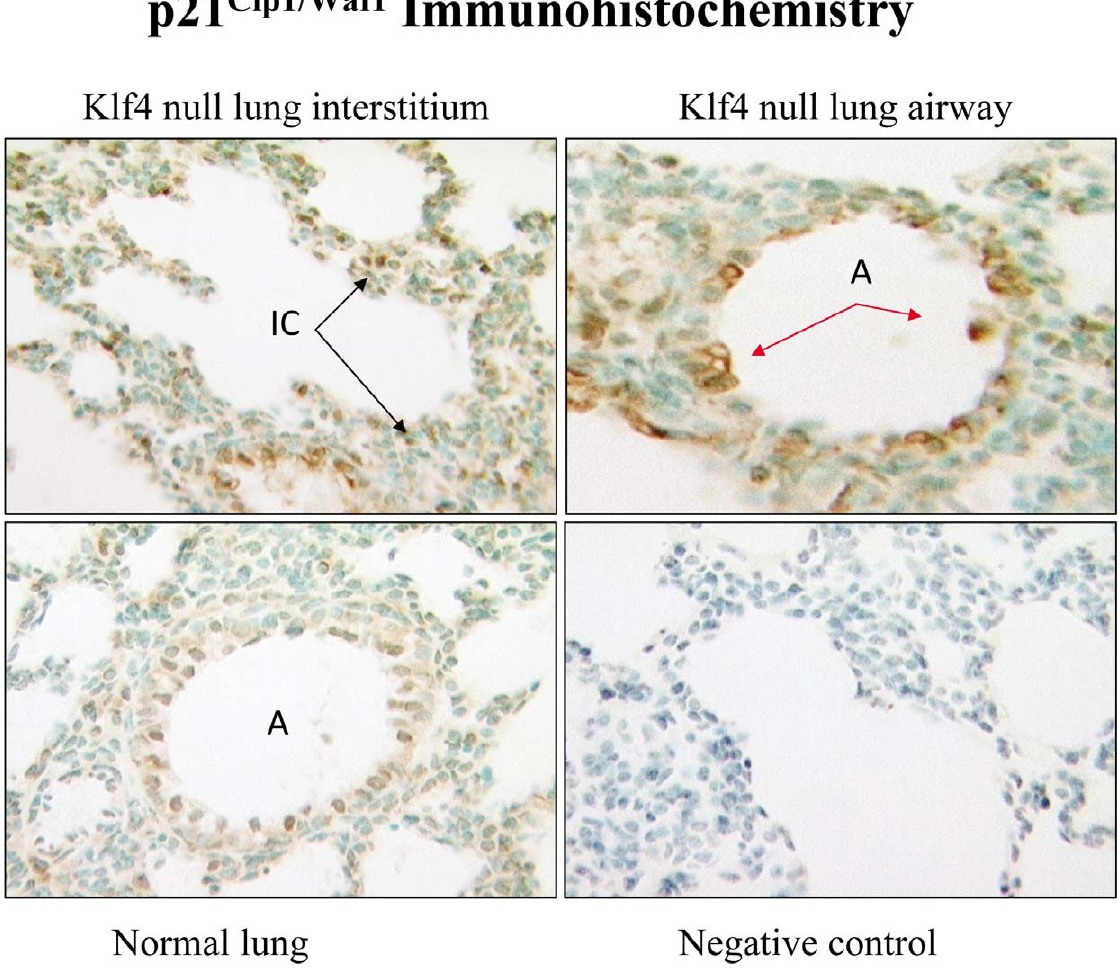
Figure 11. Immunohistochemisry for p21 cip1/Waf1 protein. An intense nuclear immunohistochemical signal (brown color) for p21 cip1/Waf1 protein is present in numerous interstitial (IC) cells (top left panel) and airway epithelial (A) cells (top right panel) of Klf4 null lung at birth. Signal is sparse in normal lung (bottom left panel) and absent with omission of primary antibody as the negative control (bottom right panel).